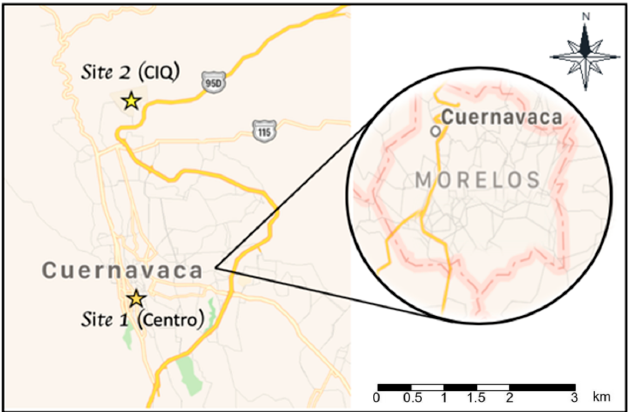
Figure 1. Sampling sites at the city of Cuernavaca, Morelos.